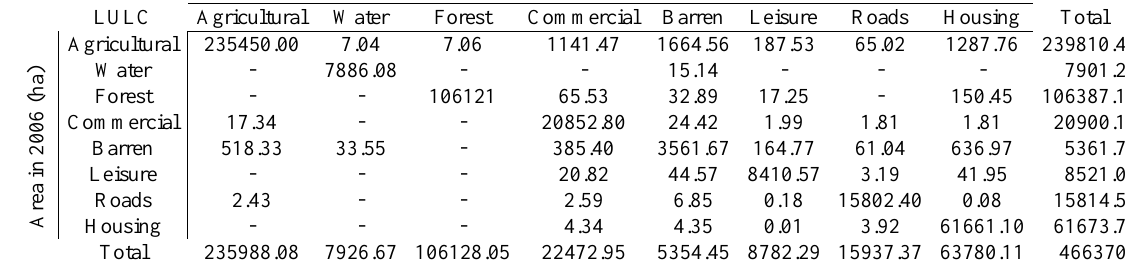
Table 2. LULC Change matrix for the time period